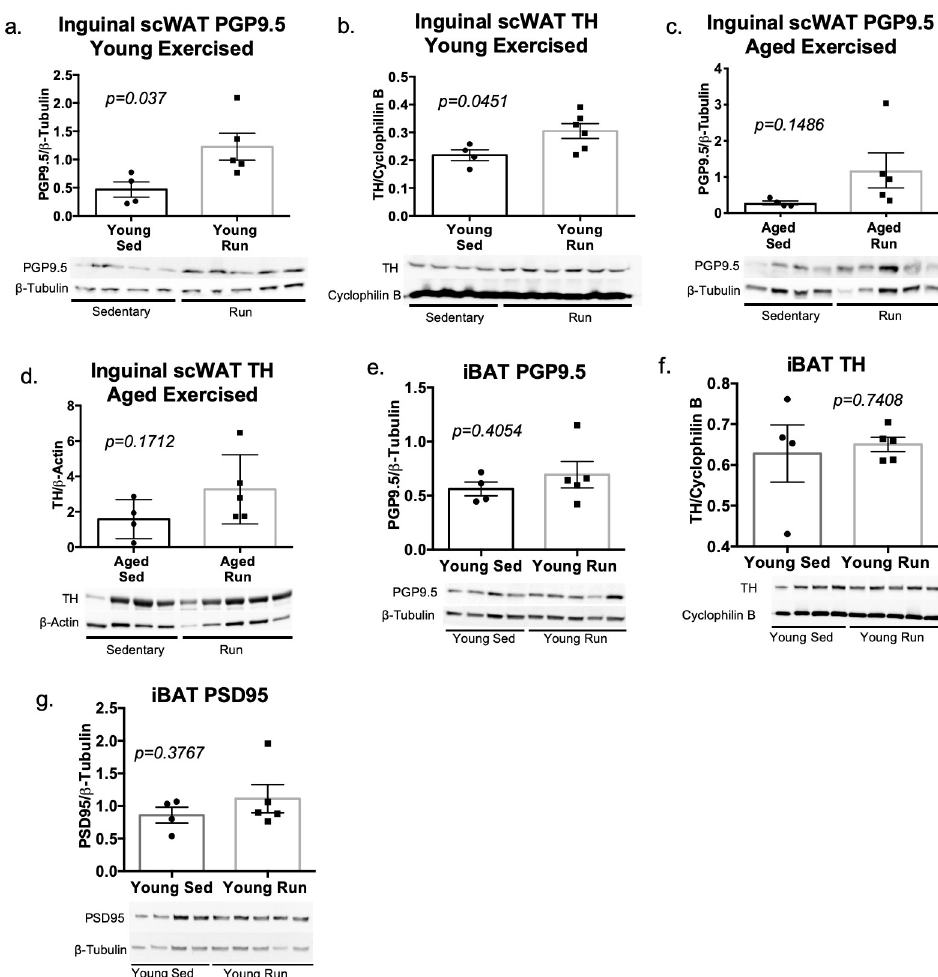
Fig 5. Exercise increases adipose innervation in young mice and attenuated loss of age-related adipose innervation. Young (10–12 weeks old) and aged (16 months old) male C57BL/6J mice were placed in running-wheel cages for 7 days with continuous access to a running wheel (run). To assess exercise effects on adipose innervation in young mice, protein expression in inguinal scWAT was measured by western blotting with PGP9.5 as a marker of total innervation (a), and TH as an indicator of sympathetic activation (b). Protein expression was normalized to either β - Tubulin or Cyclophilin B. Band intensity was quantified in Image J and analyzed by two-tailed Student’s t-test; N = 4 for young sedentary and N = 5–6 for exercised groups. Protein expression of PGP9.5 (c) and TH (d) in inguinal scWAT of aged sedentary and exercised mice was also determined by western blotting. Protein expression was normalized to β -Tubulin or β -Actin, band intensity was quantified in Image J and analyzed by two-tailed Student’s t- test; N = 4 for aged sedentary animals, N = 5 for aged exercised (run) animals. Young (12–15 weeks old) male C57BL/ 6J mice were placed in running-wheel cages for 7 days with continuous access to a running wheel (run), control (sed) animals were placed in cages with a locked running wheel. Error bars are SEMs. Protein expression of PGP9.5 (e), TH (f), and PSD95 (g) in iBAT of young (12 week old) sedentary (young sed) versus young exercised (young run) mice was determined by western blotting. Protein expression was normalized to β -Tubulin or Cyclophilin B; band density was quantified in Image J and analyzed using a two-tailed Student’s t-test. Error bars are